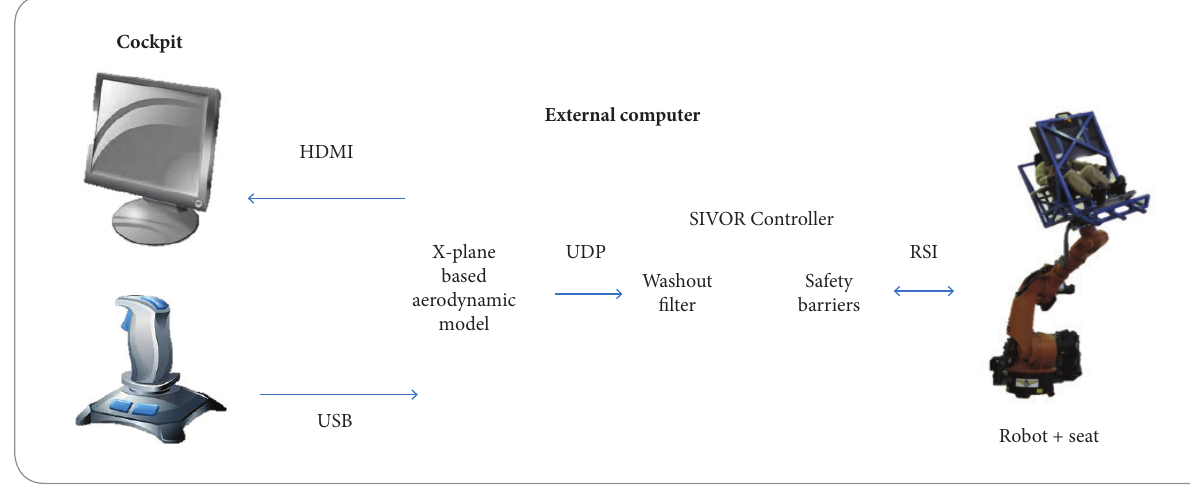
Figure 3. Control architecture of the SIVOR